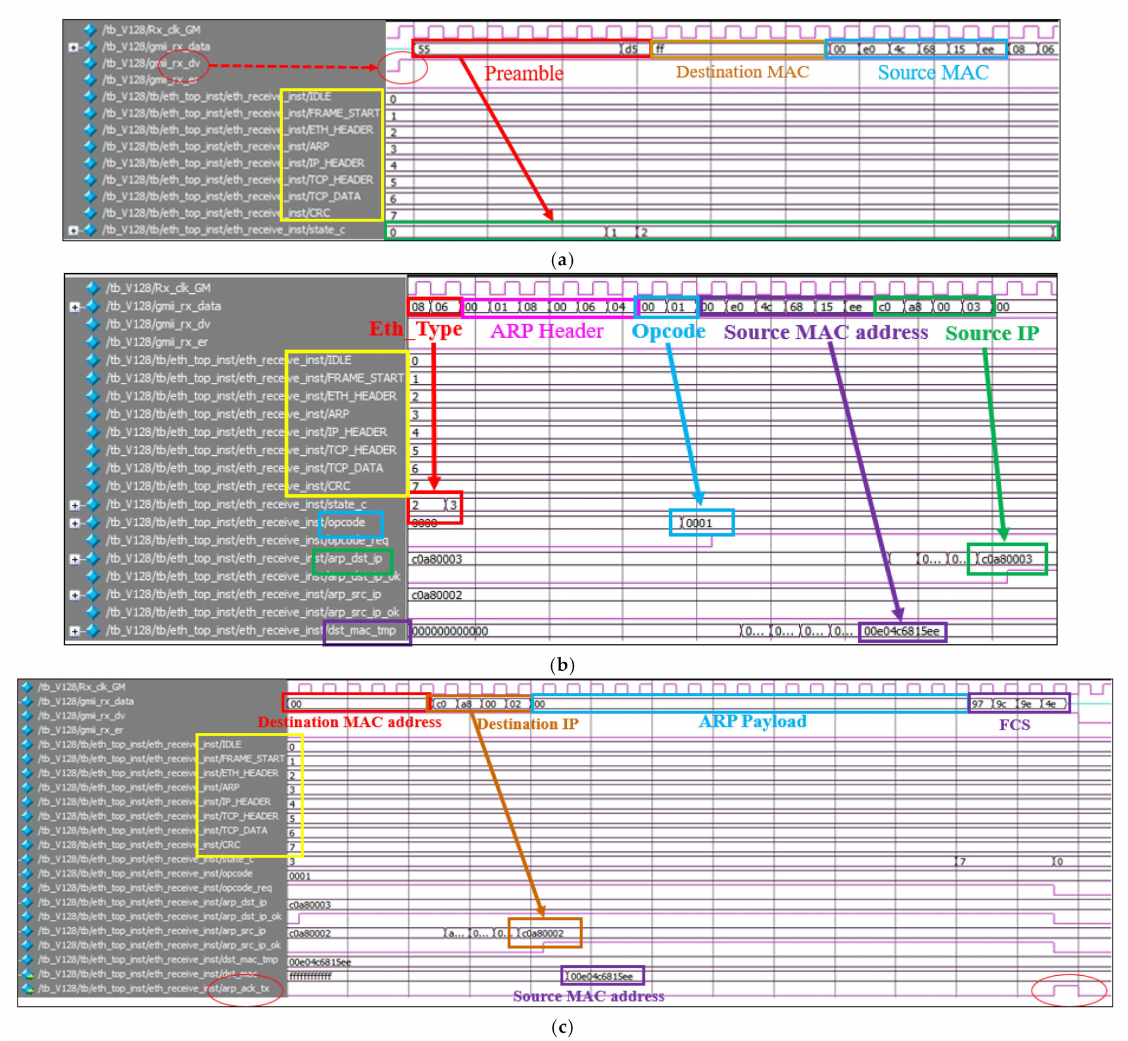
Figure 10. The Ethernet module confirms the control signals and received data types of the Ethernet Modbus/TCP packets. ( a ) Part I; ( b ) Part II; ( c ) Part